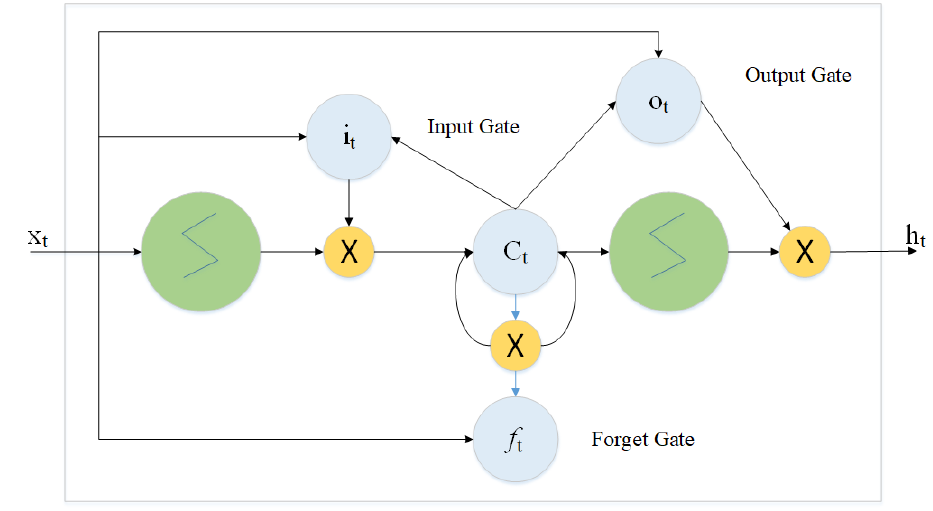
Figure 1. A cell of